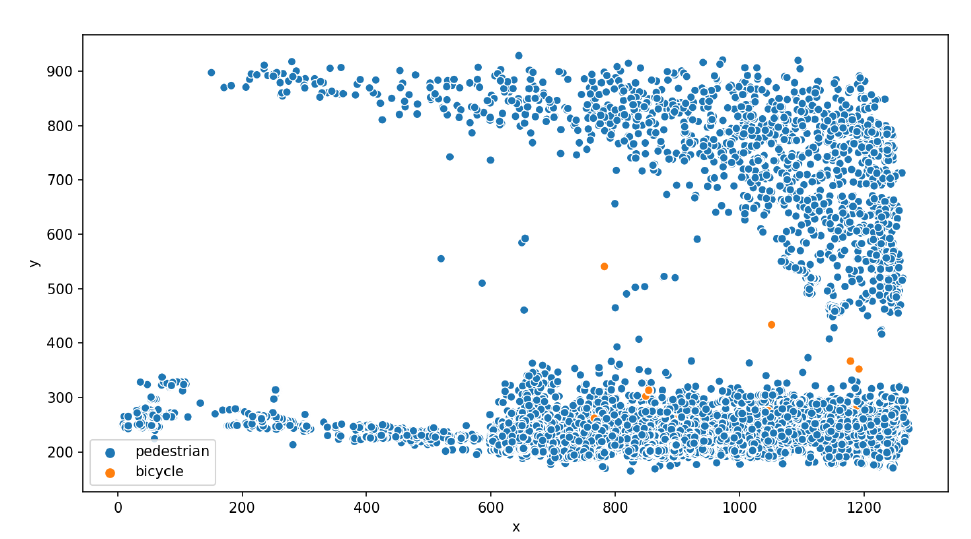
Figure 20. Plot of the pixel coordinates ( X , Y ) of the detected pedestrians (blue) or bicycles (orange) in the frame for the day 23 February 2019. Each dot represents the centroid of the bounding box corresponding to an item that has been detected at those